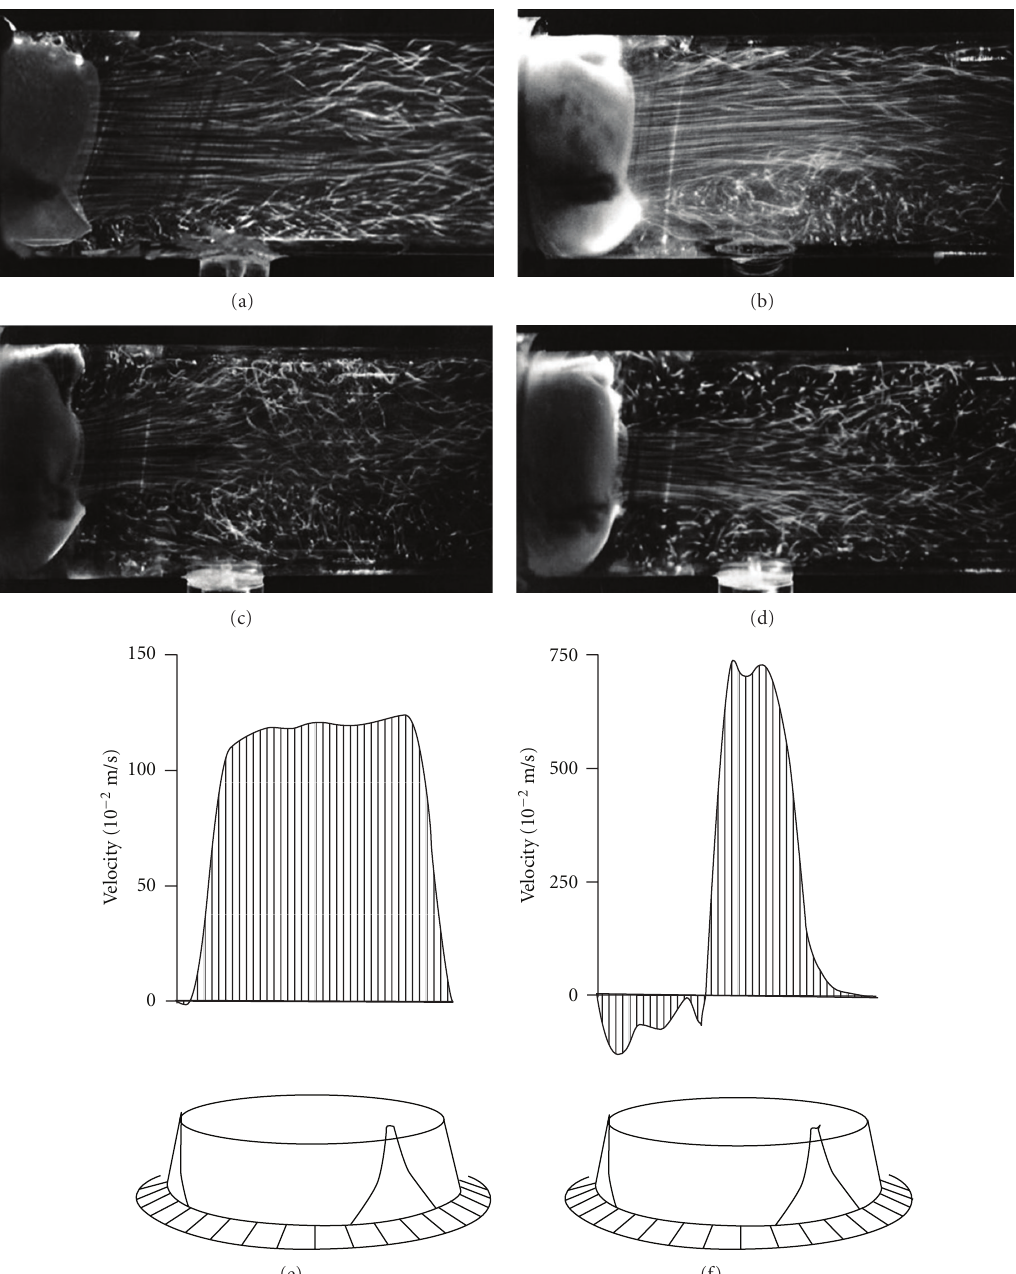
Figure 2: Flow patterns created at peak systole by di ff erent stenotic bioprosthetic aortic valves: (a) normal; (b) mildly stenotic; (c) moderately stenotic; (d) severely stenotic valves [6]. Schematic velocity profile at peak systole distal to (e) the normal aortic valve and (f) severely stenotic aortic valve